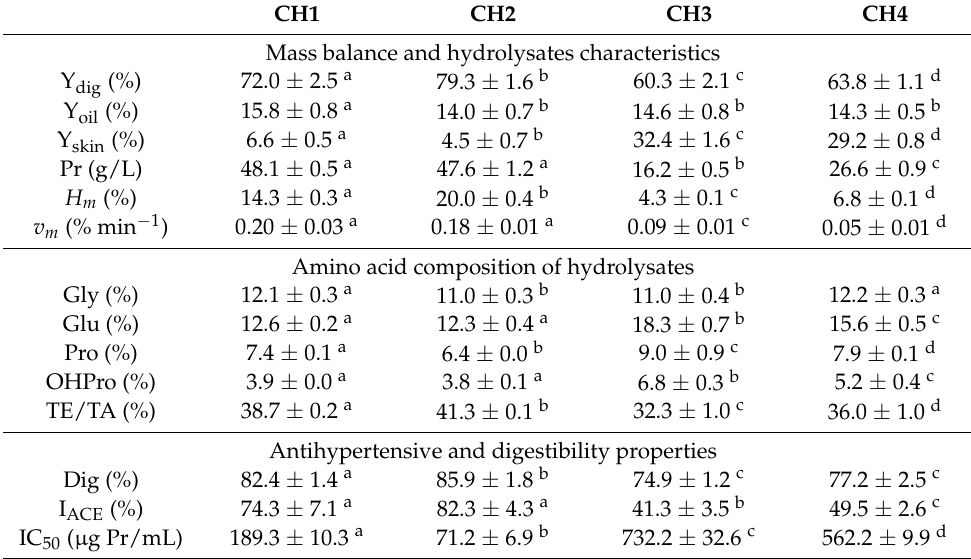
Table 7. Mass balance, chemical, and bioactive properties of hydrolysates from salmon skin residues applying alcalase (CH1 and CH2) and papain (CH3 and CH4). Y dig : yield of digestion process. Y oil : percentage of oil recovered. Y skin : percentage of final solid produced (non-digestible skin). Pr: soluble protein by Lowry method. Hm: maximum hydrolysis degree from Weibull equation. vm : maximum rate of hydrolysis from Weibull equation. I ACE : maximum ACE activity. IC 50 : protein-hydrolysate concentration that generates a 50% of I ACE . Different letters (a, b, c, and d) in each column (as superscript) mean significant difference between hydrolysates ( p < 0.05). CH1 CH2 CH3 CH4 Mass balance and hydrolysates characteristics